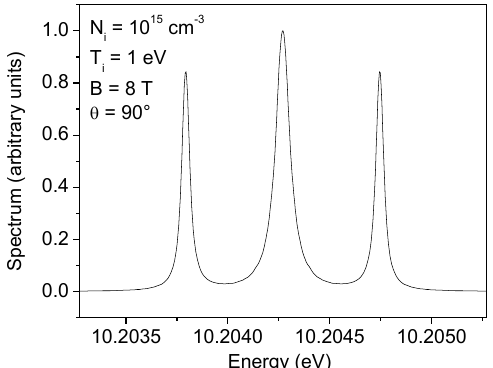
Figure 1. Plot of hydrogen Lyman α line shape calculated in dense tokamak divertor plasma conditions. The spectrum in the atomic frame of reference is shown here, i.e., Doppler broadening due to thermal motion is not retained. See text for details on the calculation. The separation between the components is proportional to the magnetic field.